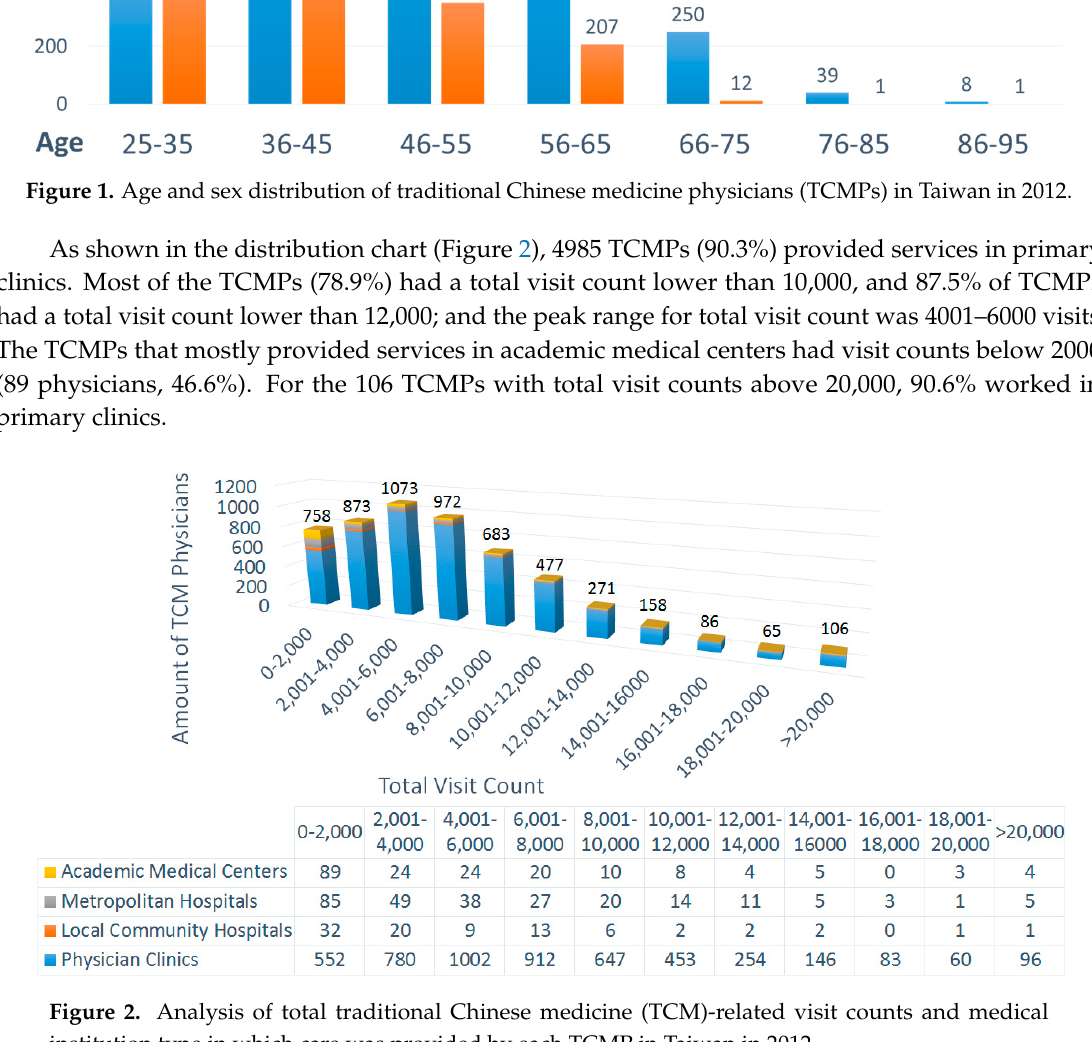
Figure 2. Analysis of total traditional Chinese medicine (TCM)-related visit counts and medical institution type in which care was provided by each TCMP in Taiwan in 2012.